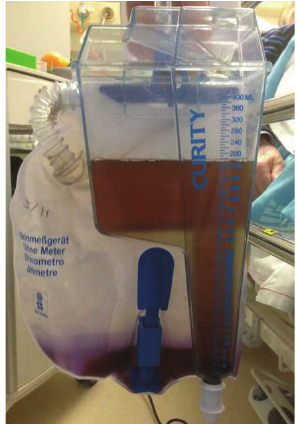
Figure 2: Purple color of the urine bag. Note that the color of the urine in the collection device before entering the bag is